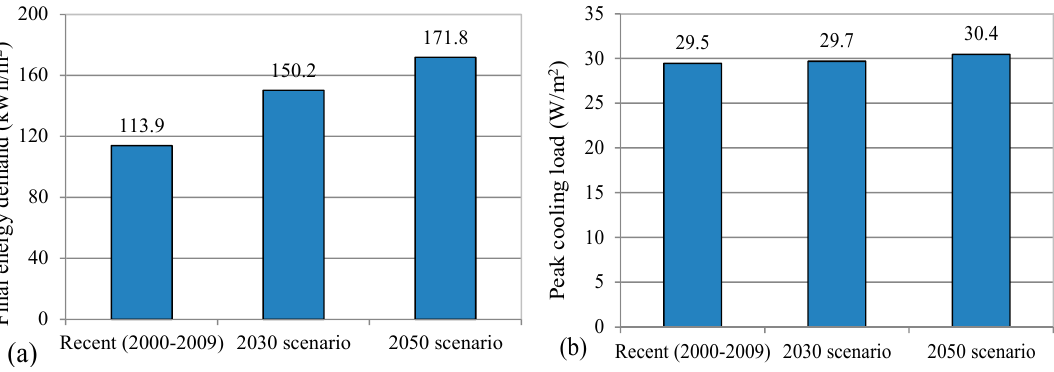
Figure 6. Specific annual cooling energy demands ( a ) and peak cooling loads ( b ) for the building under recent and projected future climates.